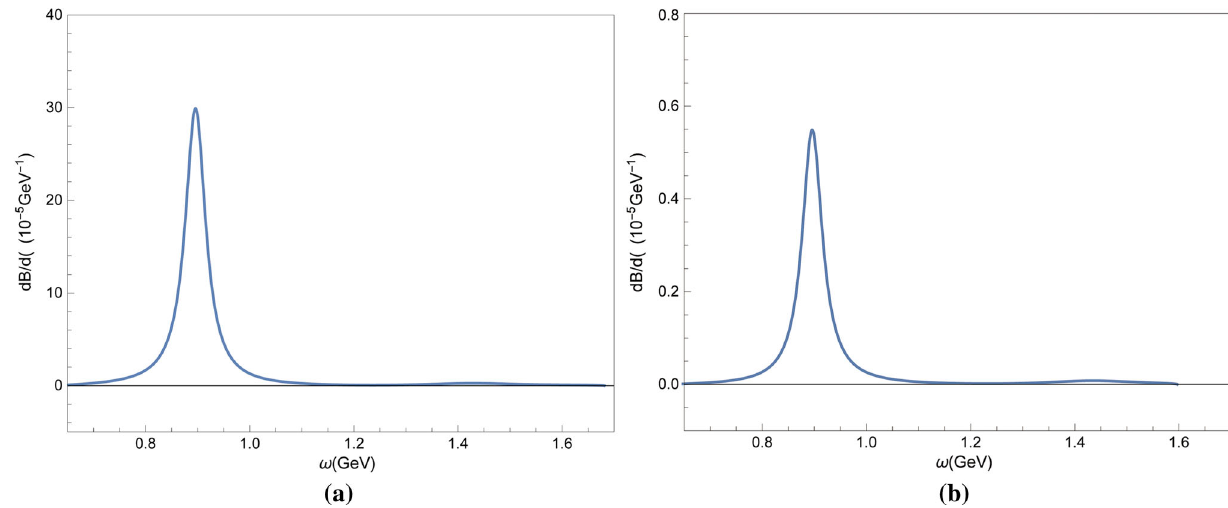
Fig. 3 Differential branching ratios of the P-wave for a B 0 s → ψ( 2 S ) K − π + and b B 0 s → ψ( 1 D ) K − π +